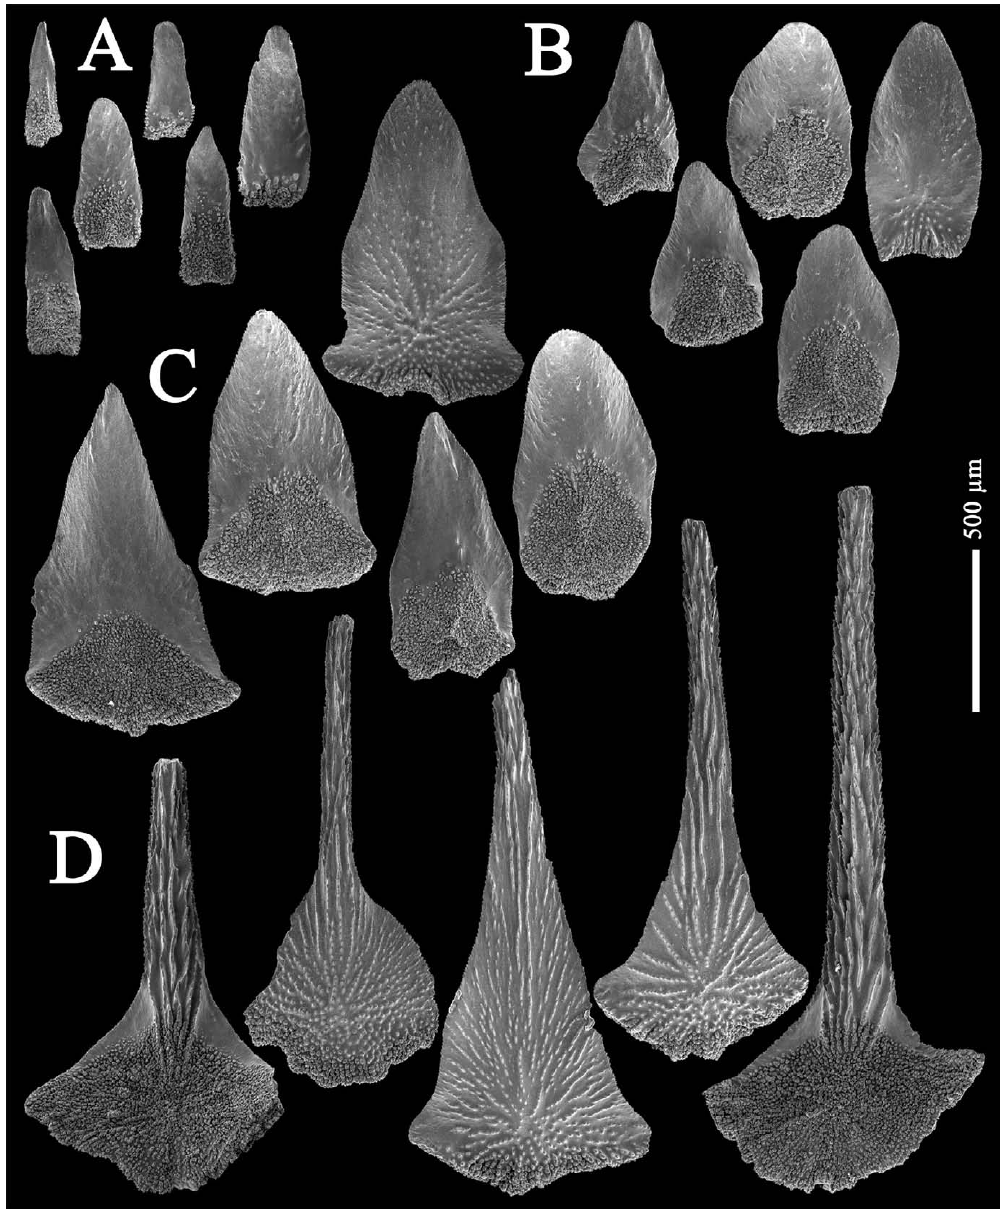
Fig . 6. – Thouarella sardana n. sp., holotype ZiZMH c11740: accessory opercular scales (a). opercular scales from inner (b) and outer (c) alternate cycle. Marginal scales